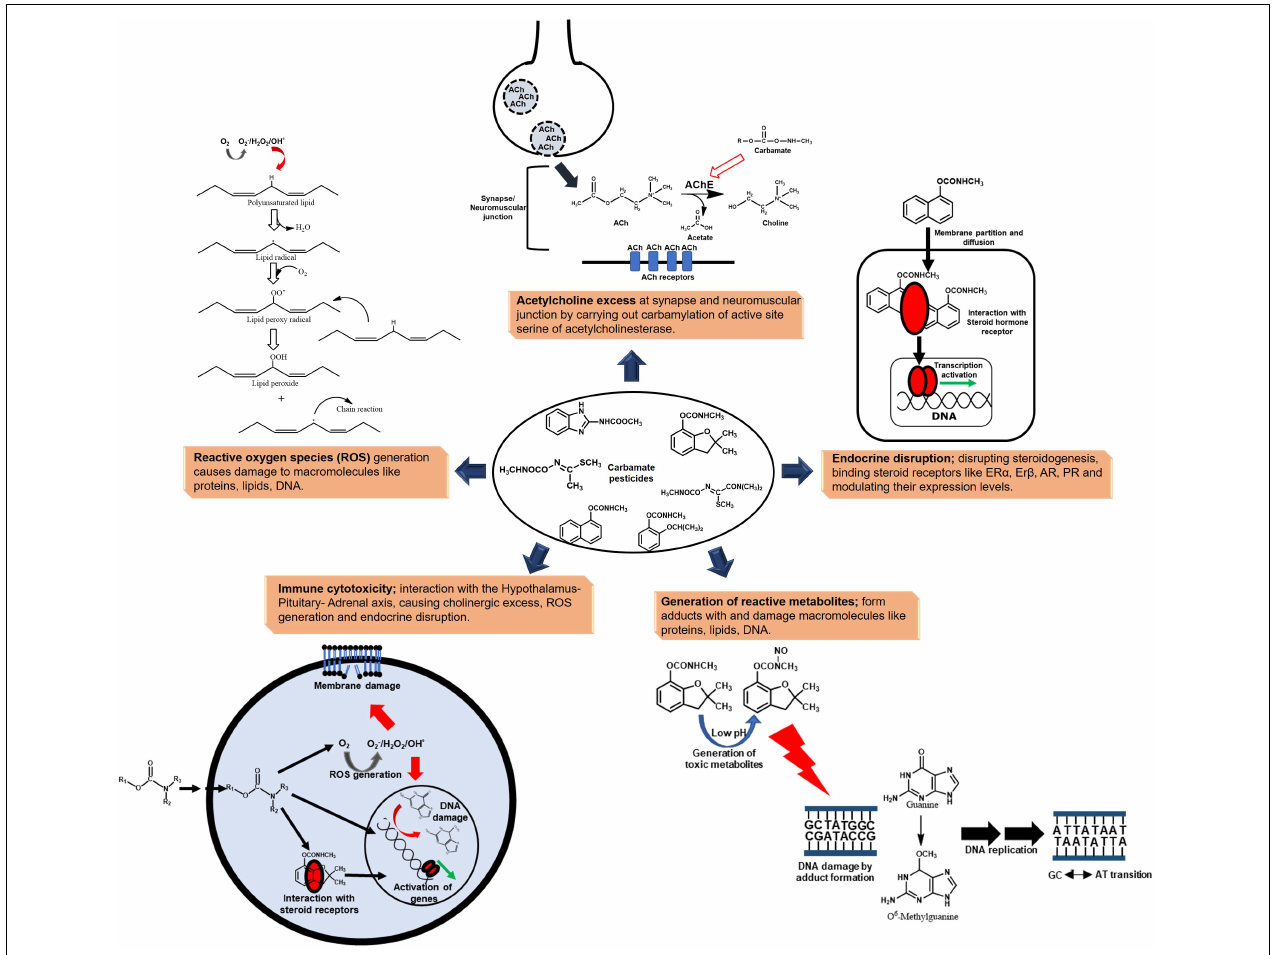
FIGURE 2 | Toxicity of carbamate pesticides manifested at various levels to humans and non-target